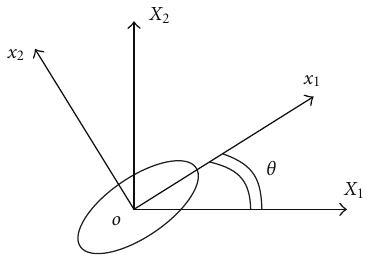
Figure 3: Elliptical gate in coordinate systems x 1 ox 2 and X 1 OX 2 .